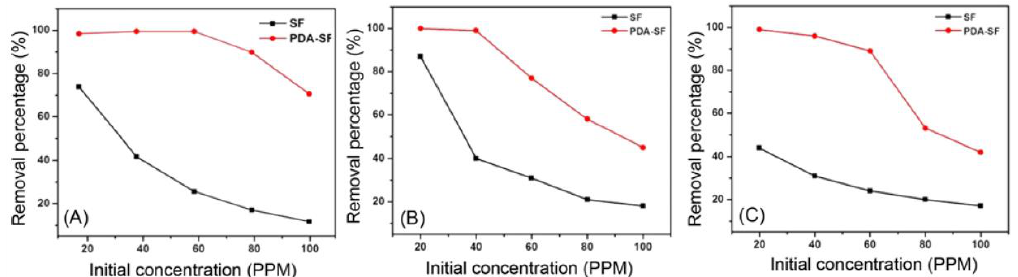
Figure 9. Initial concentration experiments on Cd 2+ ( A ), Cu 2+ ( B ) and Ni 2+ ( C ). Adapted from Reference [60]. Copyright 2021, Korean Fiber Society.